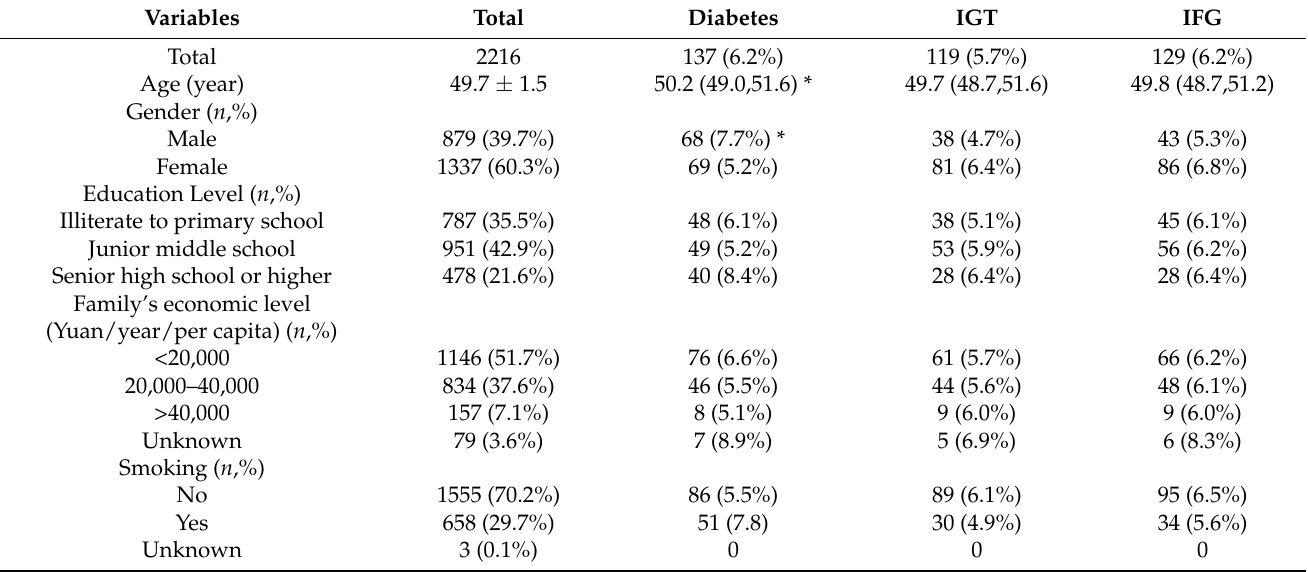
Table 1. Basic characteristics of the